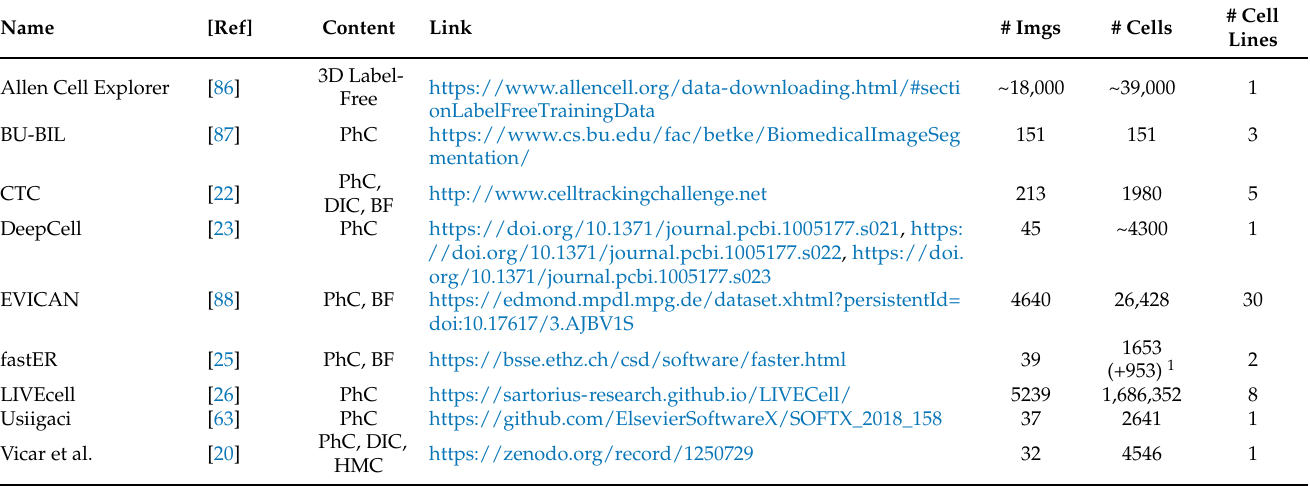
Table 2. Details of available annotated data for cell segmentation in traditional label-free images: dataset name (Name); reference ([Ref]); type of microscopy data (Content); url (Link); number of annotated images (# imgs), annotated cells (# cells), and cell lines (#cell lines). All links were accessed on 28 August